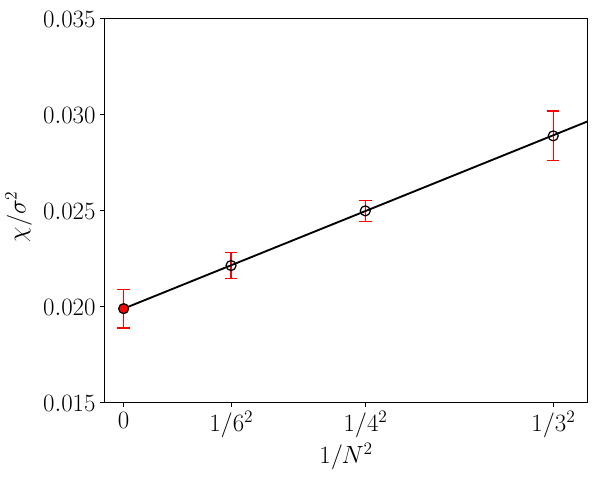
Figure 7 . Extrapolation of χ/σ 2 towards the large- N limit using fit function χ/σ 2 = ¯ χ/σ 2 + k/N 2 . Best fit yields ¯ χ/ ¯ σ 2 = 0 . 0199(10) and k = 0 .